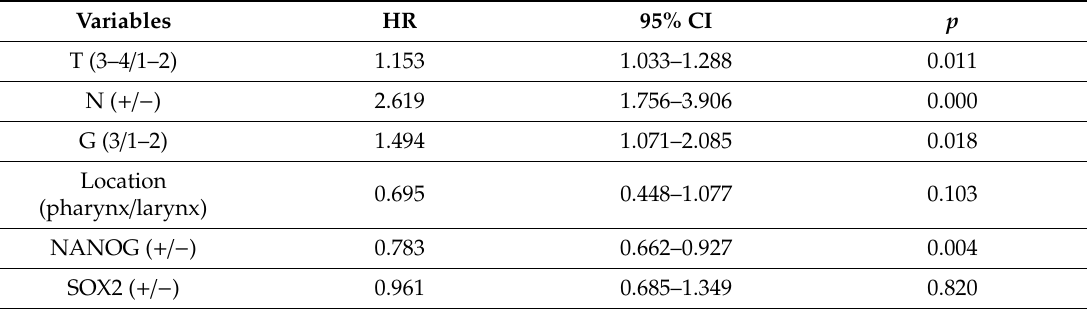
Table 2. Multivariate survival analysis (Cox